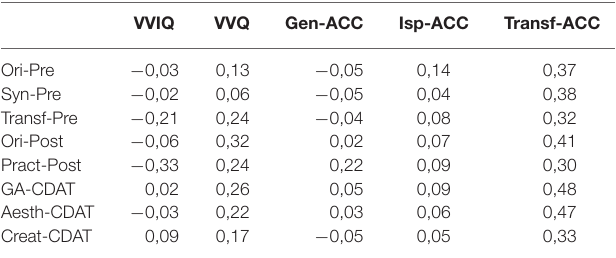
TABLE 1 | Correlation